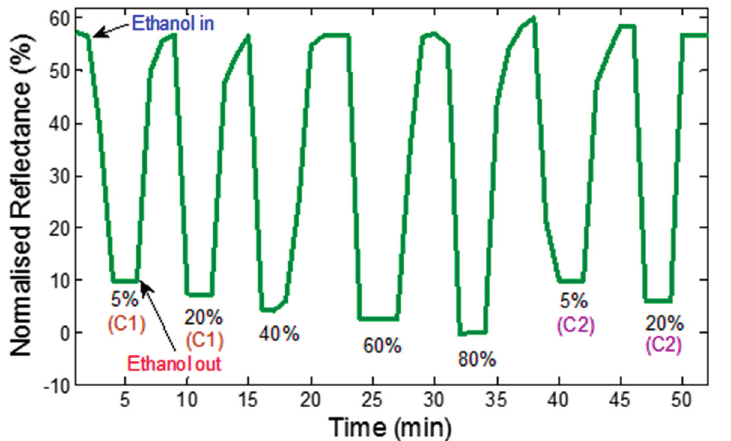
Figure 8. Dynamic response of the CNT thin film to different concentrations of ethanol operating at room temperature, integrated over wavelength range of 500–800